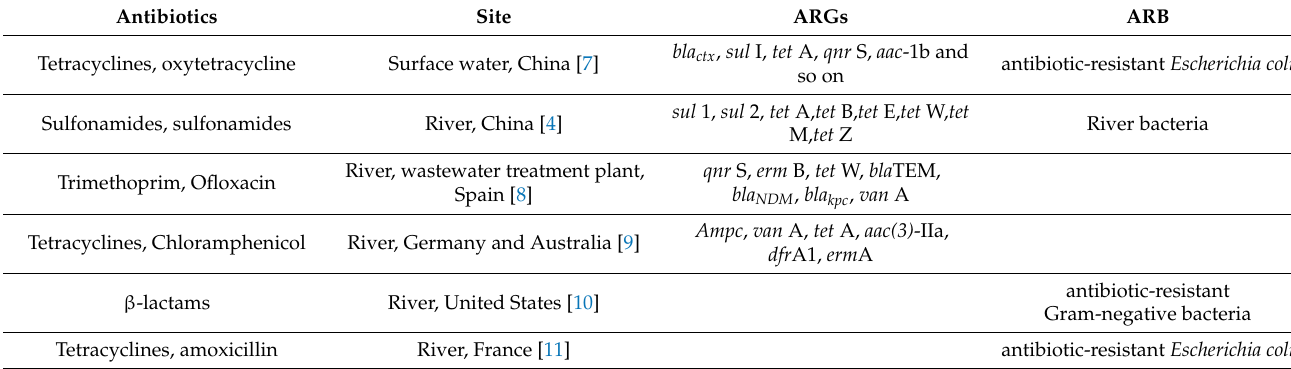
Table 1. Table 1. ARBs and ARGs detected in the natural